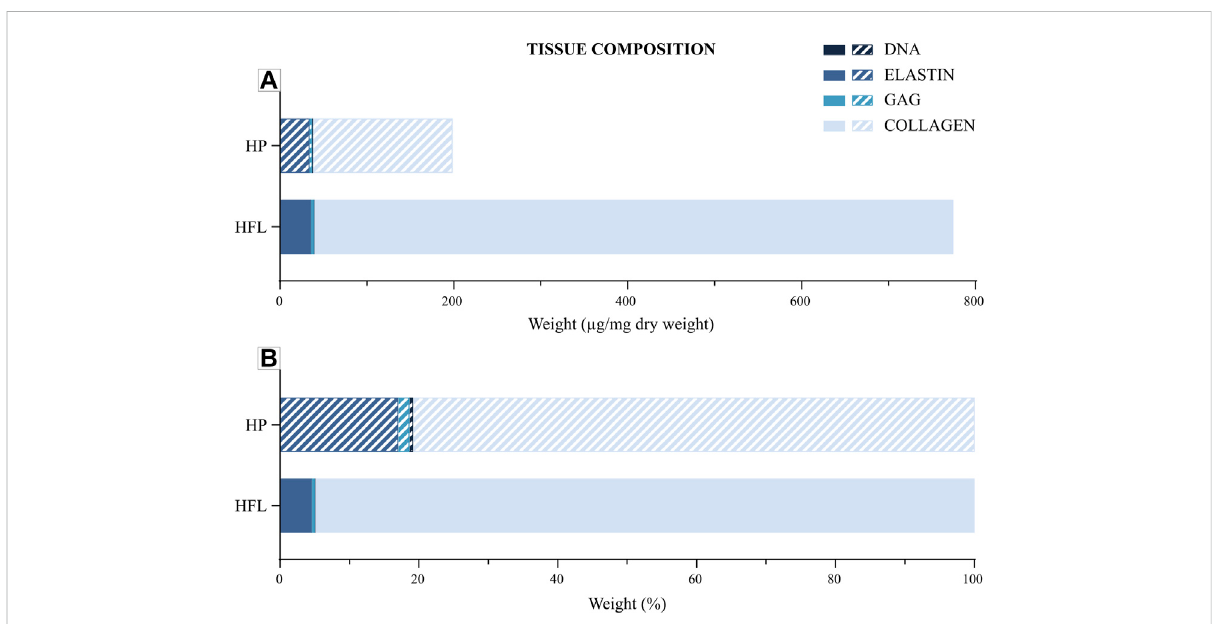
FIGURE 9 Tissue composition of periosteum and fascia lata regarding collagen, elastin, GAG and DNA depending on absolute average weight (µg/mg dry weight) (A) or relative average weight (%) (B) . HP: human periosteum, HFL: human fascia lata, GAG: glycosaminoglycans.